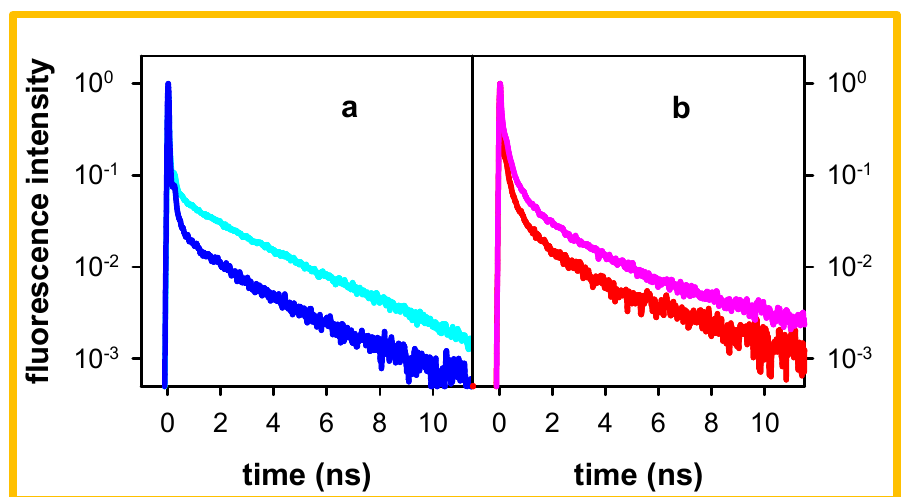
Figure 5. Comparison of the normalized fluorescence decays recorded for A 20 • T 20 (cyan and pink) and pA • pT (blue and red) in standard buffer at 305 nm ( a ) and 420 nm ( b ); excitation wavelength: 285 nm.